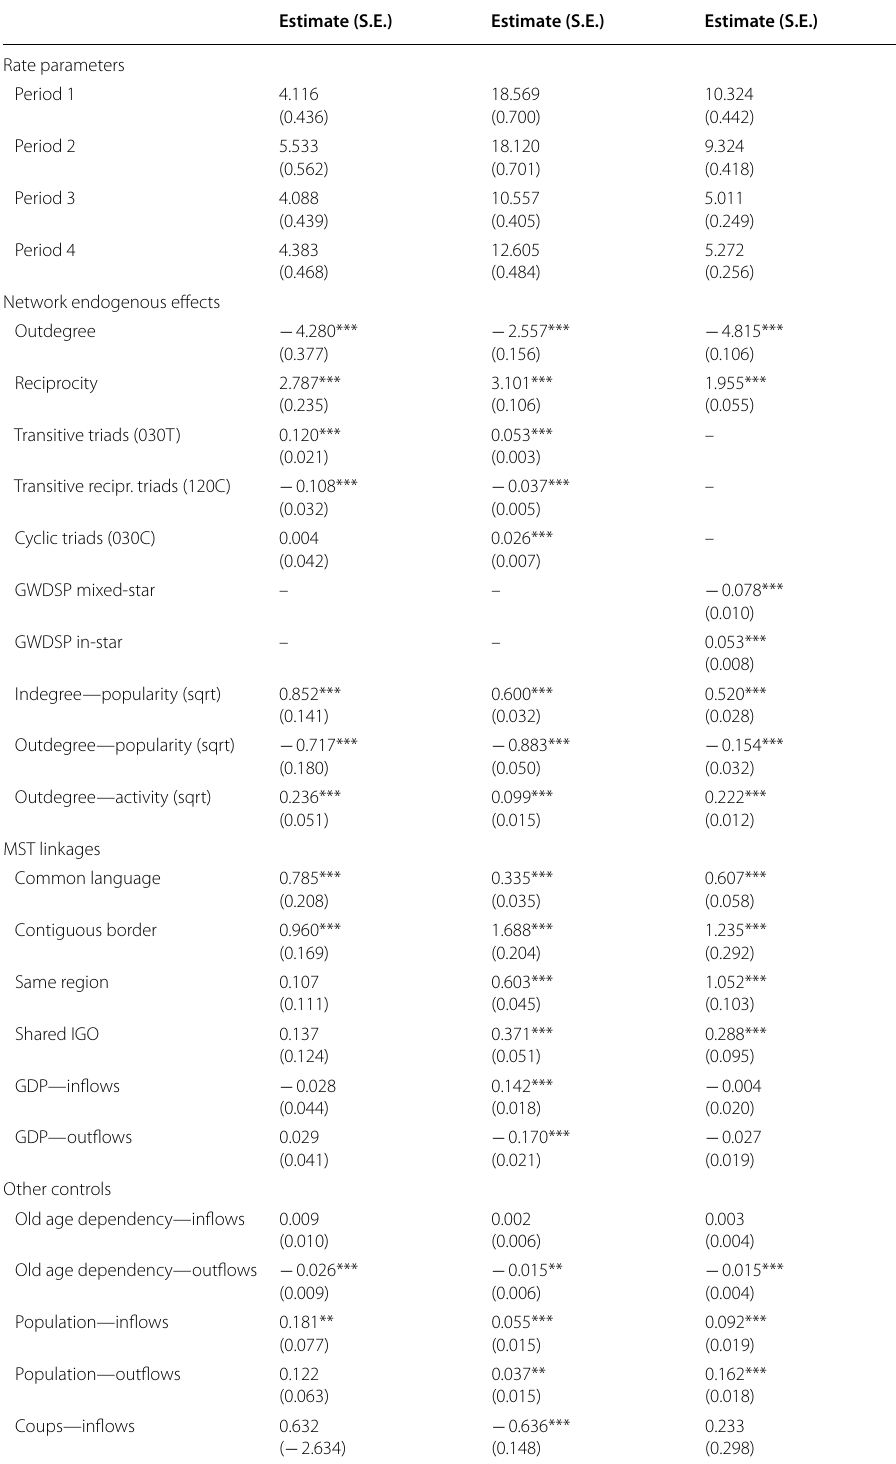
Table 3 Pooled SAOM to investigate international migration flows by the global South/ North divide